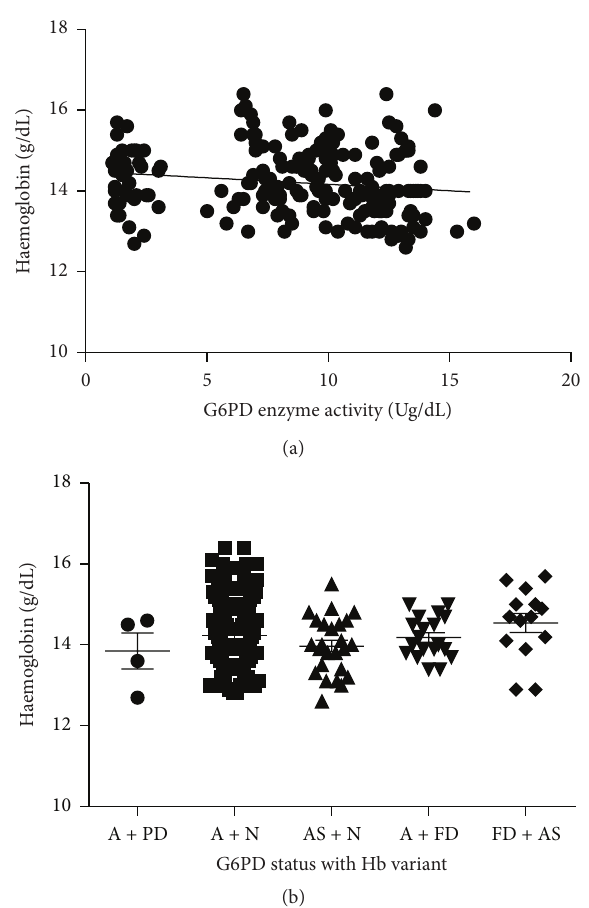
Figure 3: G6PD enzyme activity levels in relation to participant haemoglobin levels. (a) A scatter plot showing an inverse correlation between the participant haemoglobin levels and G6PD enzyme activity(Spearmancorrelationcoefficient, 𝑟 = −0.2023 ; 𝑝 = 0.0041 ). (b) Comparing the haemoglobin levels of the participants with regard to the haemoglobin variant and/or G6PD enzymopathy sta- tus (A: haemoglobin A; S: haemoglobin S; ND: no qualitative G6PD activity; FD: full qualitative G6PD defect; PD: partial qualitative G6PD defect).